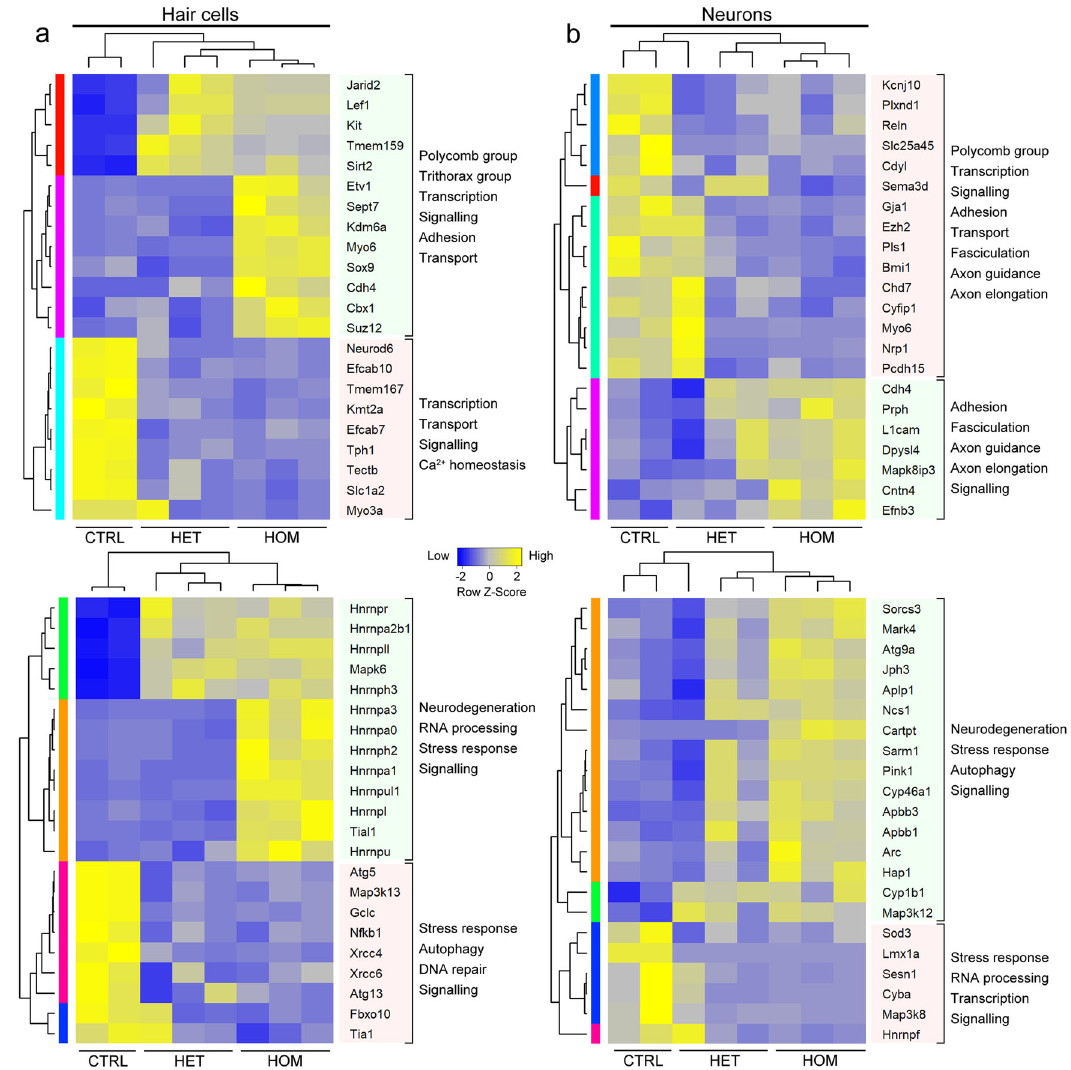
Fig. 6 Chd7 regulates RNA-splicing and stress pathway genes. a Heatmap of representative functional categories of differentially expressed genes in hair cells. b Heatmap of representative functional categories of differentially expressed genes in neurons. Highlighted blocks of genes: green = upregulated; red =